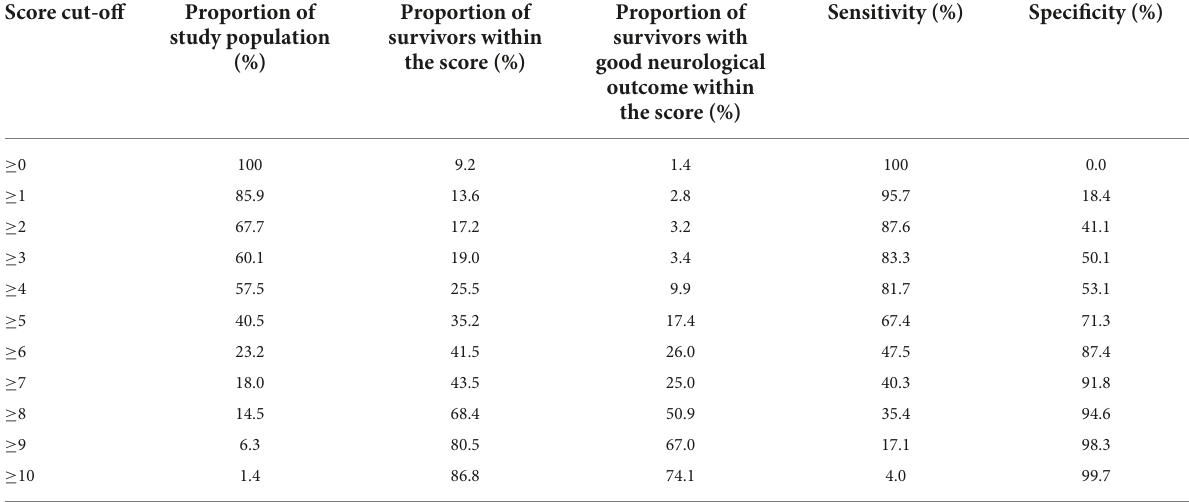
TABLE 2 Distribution of clinical outcomes by SARICA score level, along with sensitivity and specificity for each cut-off. Score